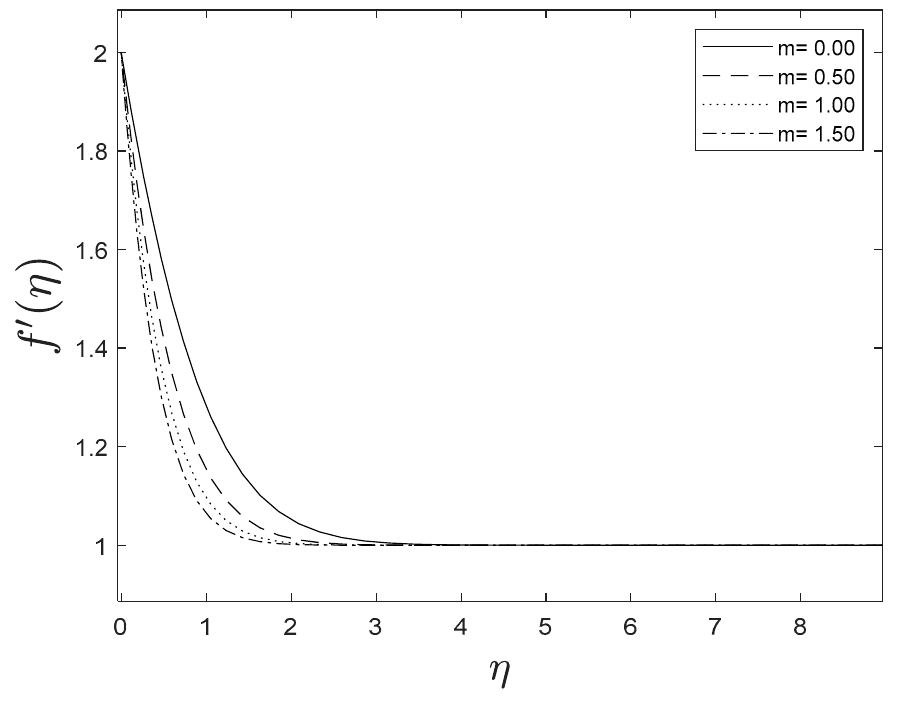
( ) ' f η . Figure 5. Effect of different values of m on f (cid:48) ( η ) ( ) ' f η .